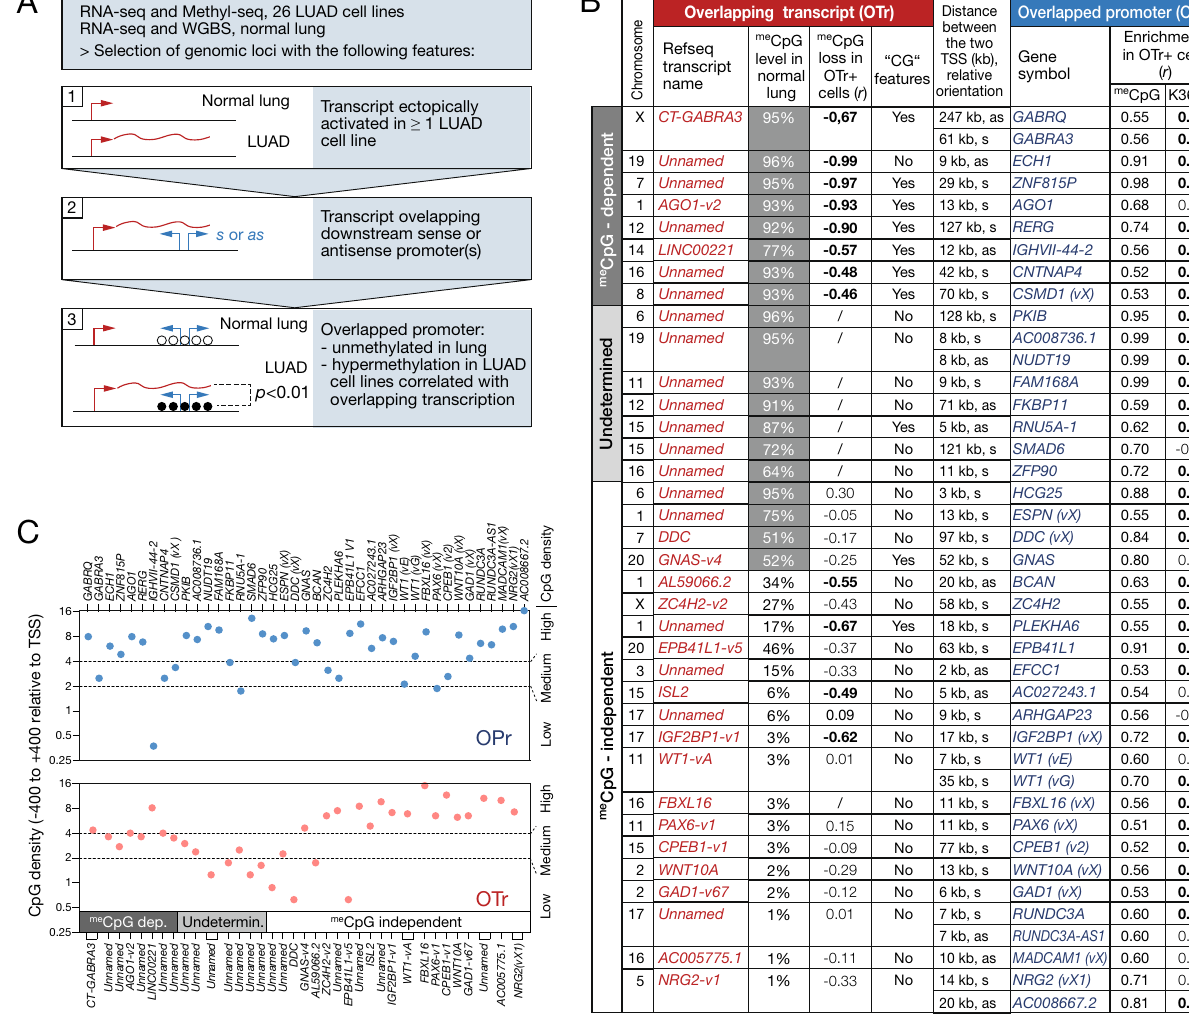
Figure 5. Identification of other genomic loci displaying correlation between DNA hypermethylation of an overlapped promoter (OPr) and activation of an overlapping transcript (OTr) in LUAD cell lines. ( A ) Flowchart of the bioinformatics selection procedure. Broken arrows indicate positions of transcription start sites, wavy lines correspond to overlapping transcription, and empty or filled circles represent unmethylated or methylated CpGs, respectively. ( B ) Features of selected genomic loci. For OPrs, the table provides: distance from TSS of OTr; gene symbol (with transcript variant according to NCBI RefSeq descriptions, or indicated as vX when the variant was undescribed); Pearson coefficient of correlation between OTr activation and promoter CpG methylation; Pearson coefficient of correlation between OTr activation and promoter H3K36me3 (coefficient in bold if adjusted p- value < 0.05). For OTrs: name of transcript or transcript variant, or “unnamed” if not described in NCBI RefSeq; CpG methylation level of 5 ′ -region in normal lung; Pearson coefficient of correlation between transcriptional activation and 5 ′ -region CpG methylation level (“/” when methylation data were unavailable, coefficient in bold if adjusted p- value < 0.05); cancer-germline (“CG”) features, i.e. OTr is specifically expressed and its 5 ′ -region demethylated in testis. OTrs were categorized according to their predicted dependency ( me CpG- dependent) or independency ( me CpG-independent) on DNA demethylation for transcriptional activation in LUAD cells (see text for criteria); several OTrs were categorized “Undetermined” because methylation data in LUAD cell lines were lacking. ( C ) The number of CpGs were calculated in the genomic segments located − 400 to + 400 relative to the TSS of OPrs and OTrs. Results are expressed as number of CpGs per 100 bp, and are plotted on a log2 scale. Sequences were categorized according to CpG density: (> 4 CpG/100 bp: High, 2–4 CpG/100 bp: Medium, < 2 CpG/100 bp: